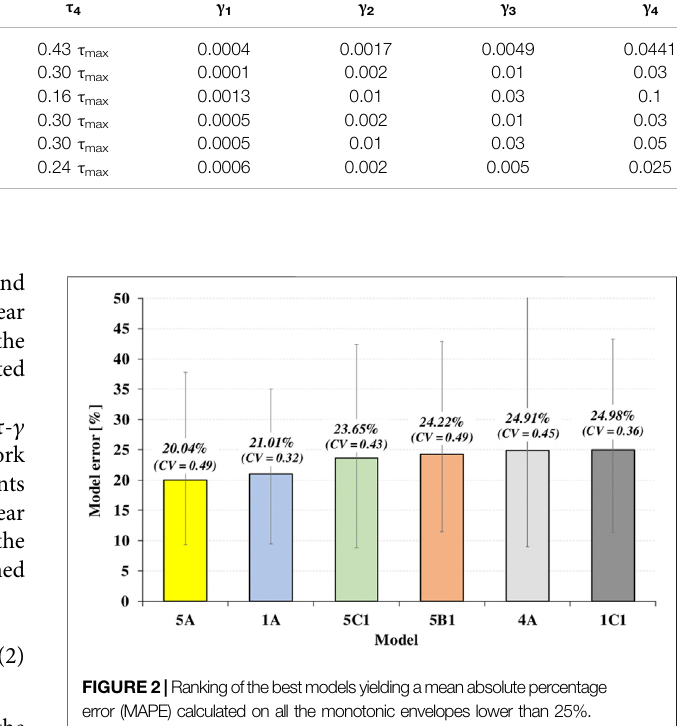
TABLE 2 | Selected literature models providing values of τ 2 , τ 4 , γ 1 , γ 2 , γ 3 , γ 4 . Model